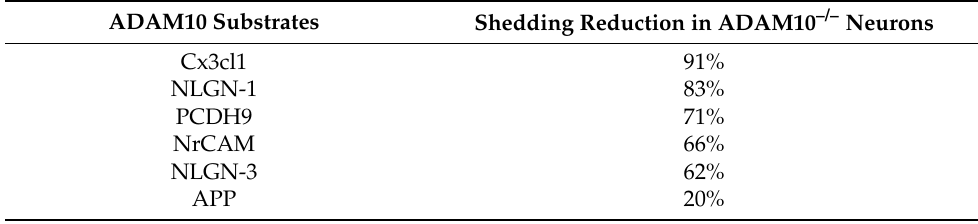
Table 1. The reduction in shedding of the A Disintegrin And Metalloprotease (ADAM)10 sub- strates after the conditional deletion of ADAM10 in embryonic primary cortical neuron cultures [35]. Abbreviations: Fractalkine (Cx3cl1), Neuroligin-1 (NLGN-1), Protocadherin-9 (PCDH9), Neural glial-related Cell Adhesion Molecule (NrCAM), Neuroligin-3 (NLGN-3) and Amyloid- β Precursor Protein (APP). Shedding Reduction in ADAM10 –/–